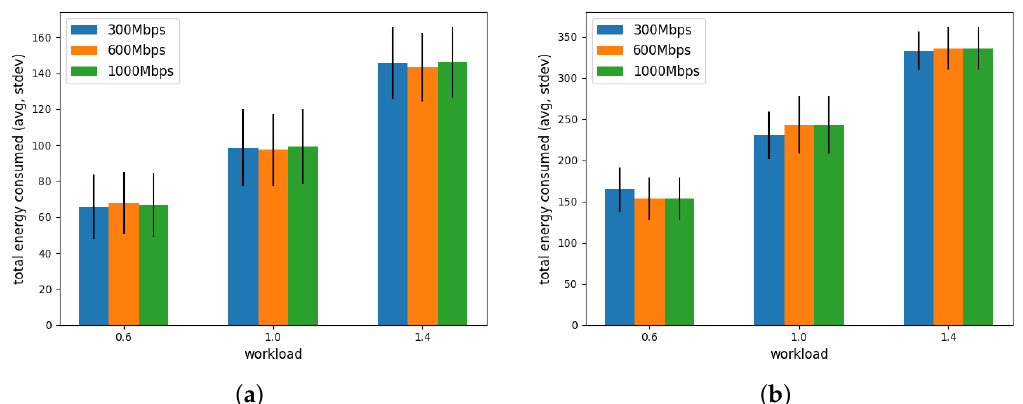
Figure 6. Impact of the backhaul network bandwidth on the total energy consumption. ( a ) 10 MECSs; ( b ) 20